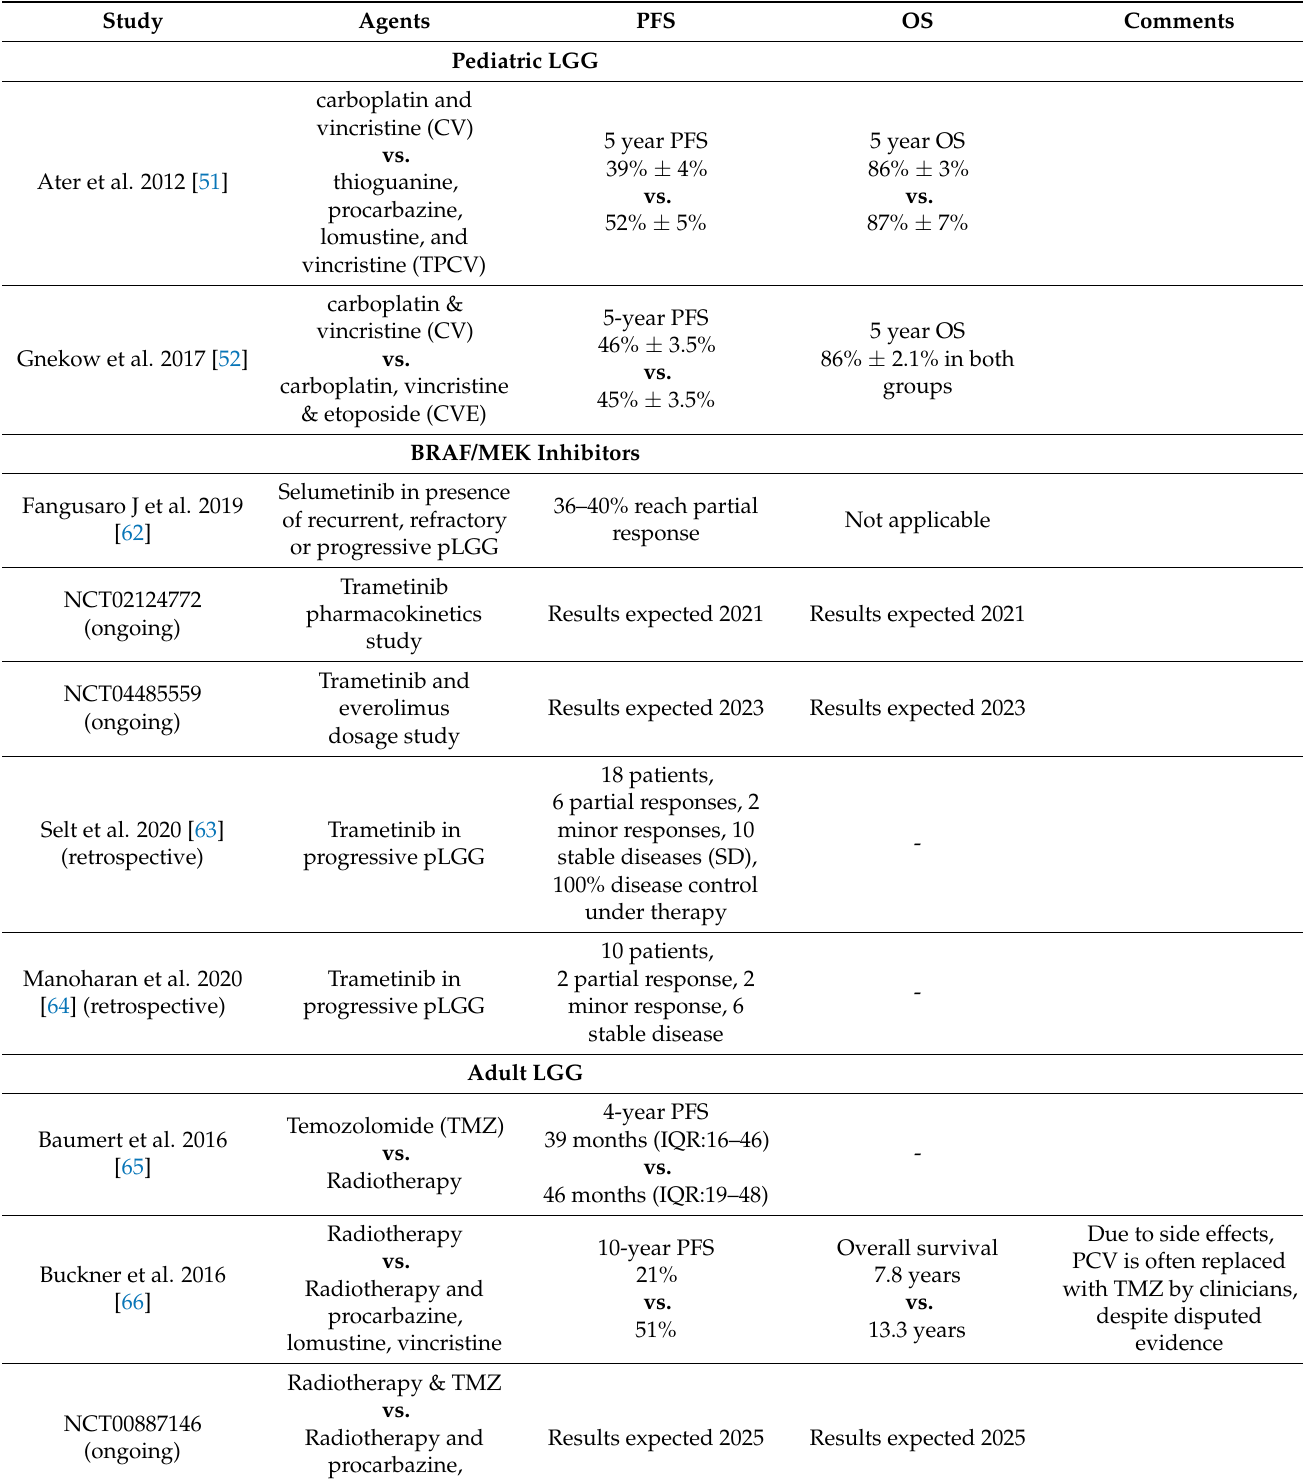
Table 2. Different randomized controlled trials comparing adjuvant regiments in LGG and ongoing trials for MEK